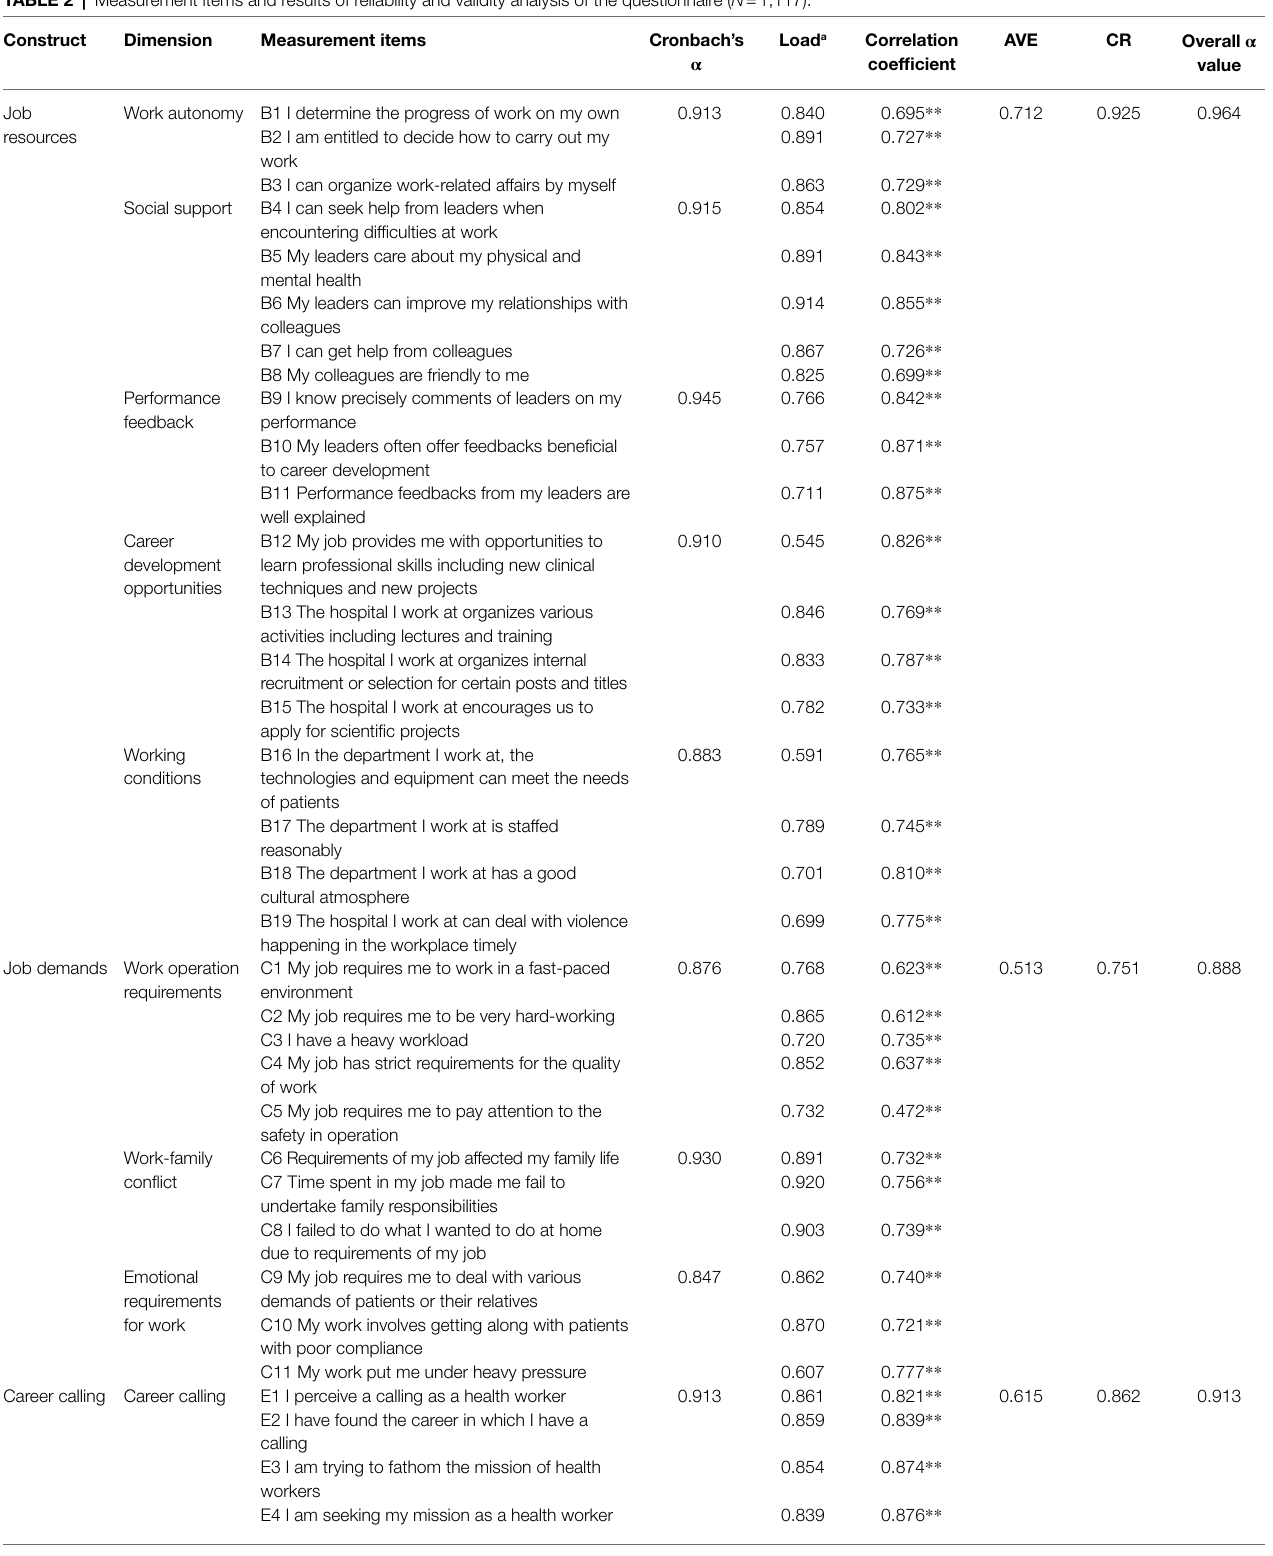
TABLE 2 | Measurement items and results of reliability and validity analysis of the questionnaire ( N = 1,117). Construct